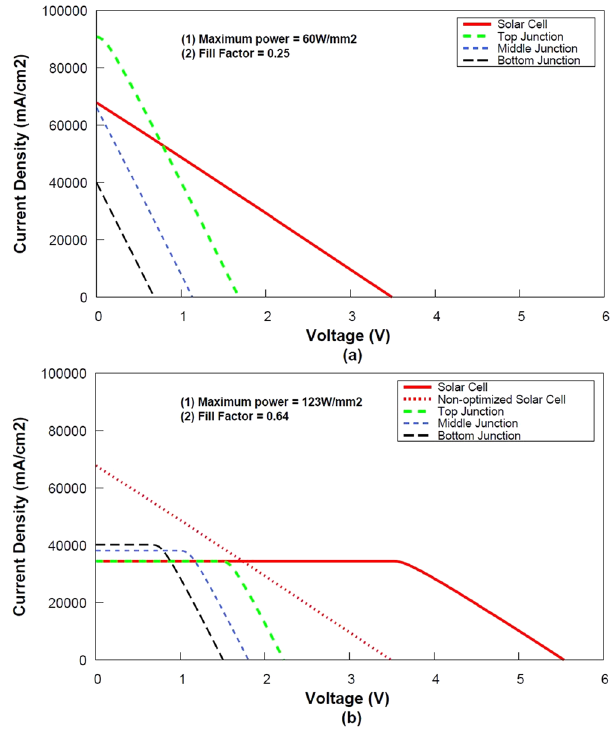
Figure 4. I - V curves of 3-J cells of non-optimized (1.75/1.18/0.7 eV) and optimized bandgap combination (Table 1) for total series resistance of 0.05 Ω cm 2 operated under 5000 suns.